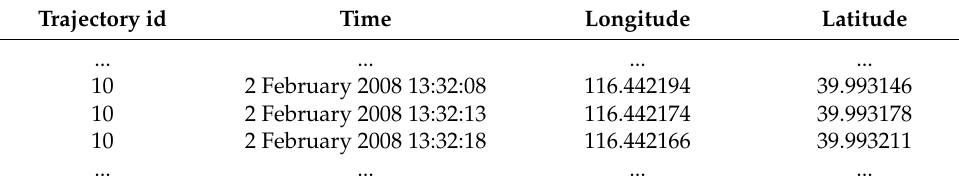
Table 2. A specific example of Beijing taxi data